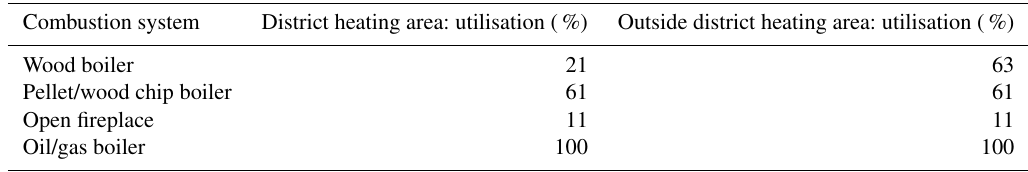
Table A3. Utilisation depending on boiler and district heating. Combustion system